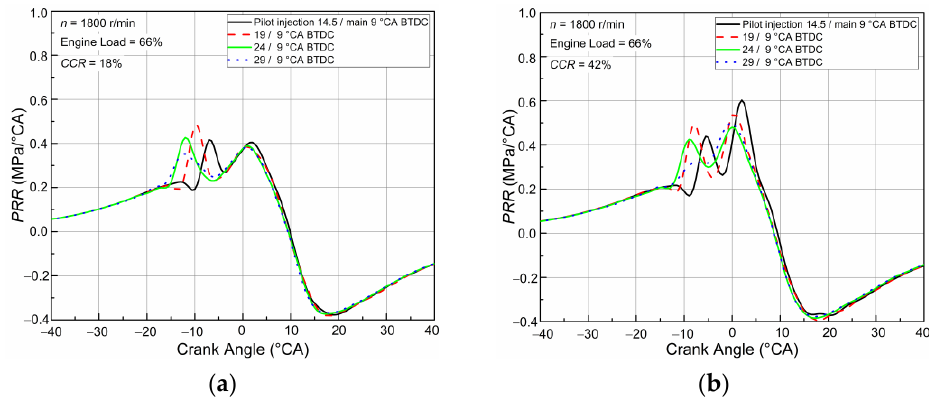
Figure 3. PRR under different pilot injection timings at 18% CCR ( a ) and 42% CCR ( b ).